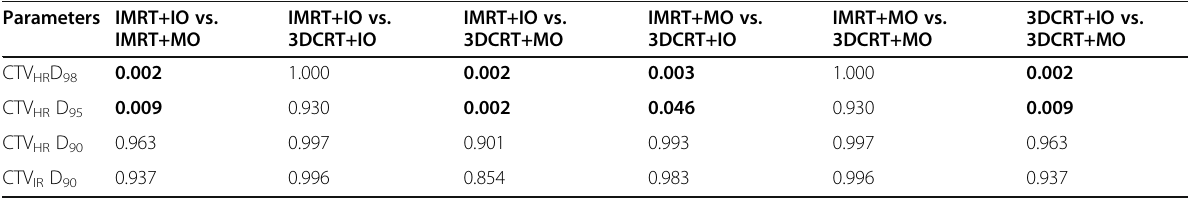
Table 3 Comparison of statistical significance for target volume Parameters IMRT+IO vs.